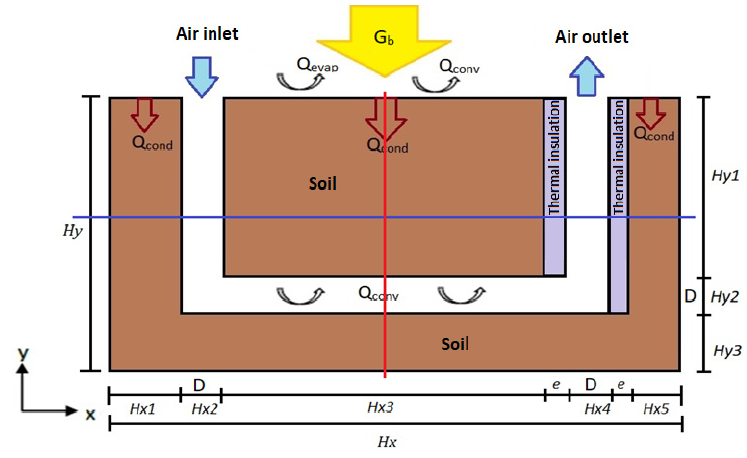
Figure 2. Physical model of the GAHE. Table 2. Dimensions of the GAHE.